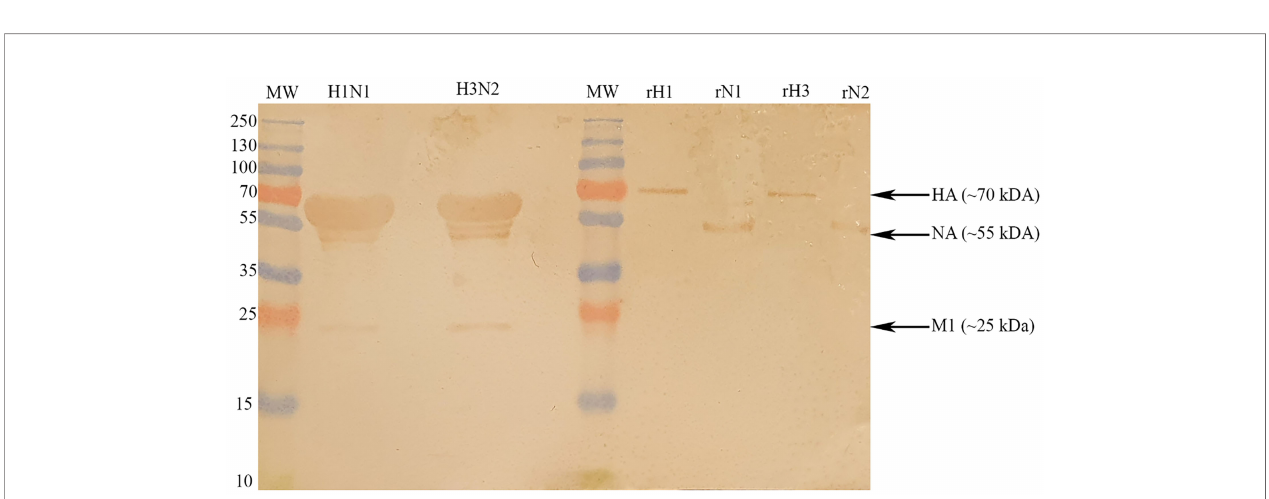
FIGURE 3 | Far-western blotting analysis to show properdin (20 µg/ml) binds HA, NA and M1 of puri fi ed H1N1 and H3N2 subtypes. 10 m l of concentrated H1N1 (Lane 2) or H3N2 (Lane 4) virus (1.36 × 10 6 pfu/ml) was fi rst run on the SDS-PAGE (12% w/v) under reducing conditions and then transferred onto a nitrocellulose membrane. Following the blocking process with PBS+5% w/v BSA, the membrane was incubated with 20 m g/ml of properdin. After PBS washes, the membrane was probed with rabbit anti-human properdin antibody (1:1000). Properdin bound to M1 ( ∼ 25 kDa), HA ( ∼ 70 kDa) and NA ( ∼ 55 kDa) in the case of both pH1N1 and H3N2 subtypes. In the same blot, the identities of properdin bound IAV glycoproteins were validated using recombinant HA and NA.